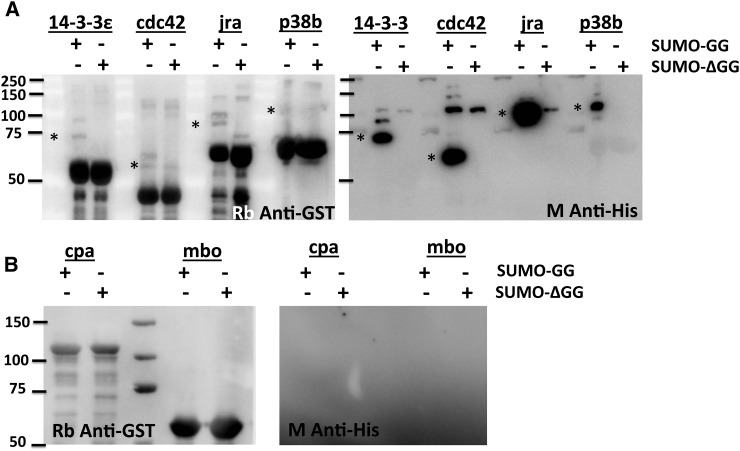
SUMOylated proteins involved in the immune response. Western blots of a subset of immune-related proteins identified in this study, as listed in Table 3. Twelve proteins were tested, using in bacto SUMOylation, with seven showing SUMOylation and five not showing SUMOylation. (A) A representative set of proteins that are SUMOylated using the in bacto assay are shown in the figure. SUMOylated proteins (marked with a *) can be identified by the presence of a weak, higher molecular weight band (15 kDa or more) in the anti-GST blots that also cross-react with the Anti-His antibody. (B) A representative set of proteins that were not SUMOylated using the in bacto assay.